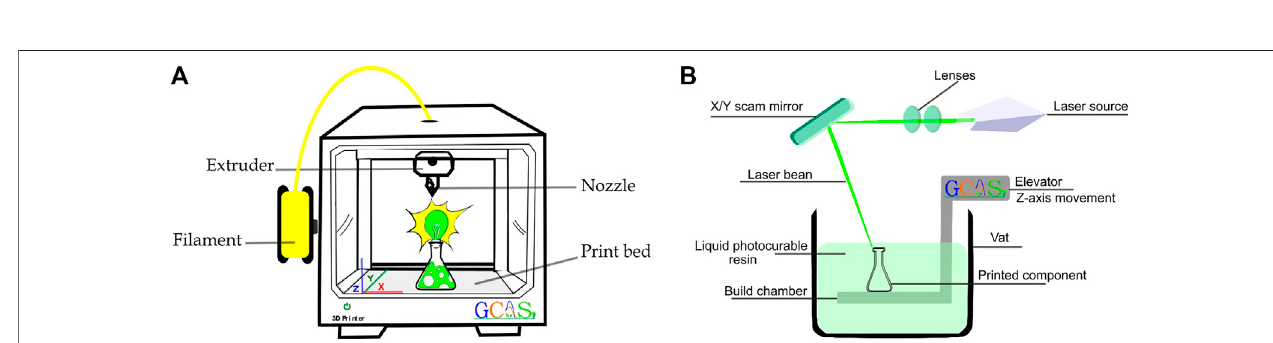
FIGURE 1 | Schematic diagram of: (A) Cartesian FFF and (B) SLA 3D printers (Source: Produced by the author).